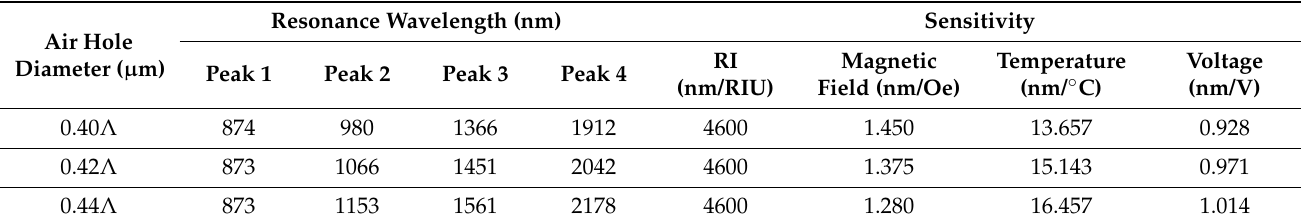
Figure 7. The loss spectrum of the core guide mode under different air hole diameters ( a ) d, ( b ) d 1 , ( c ) d 2 , and ( d ) d 3 . The variation relationship between the resonance wavelength and the external parameters under different air hole diameters d ( e ) RI, ( f ) magnetic field, ( g ) temperature, and ( h ) voltage. Table 1. Effect of air hole diameter variation on sensitivity.